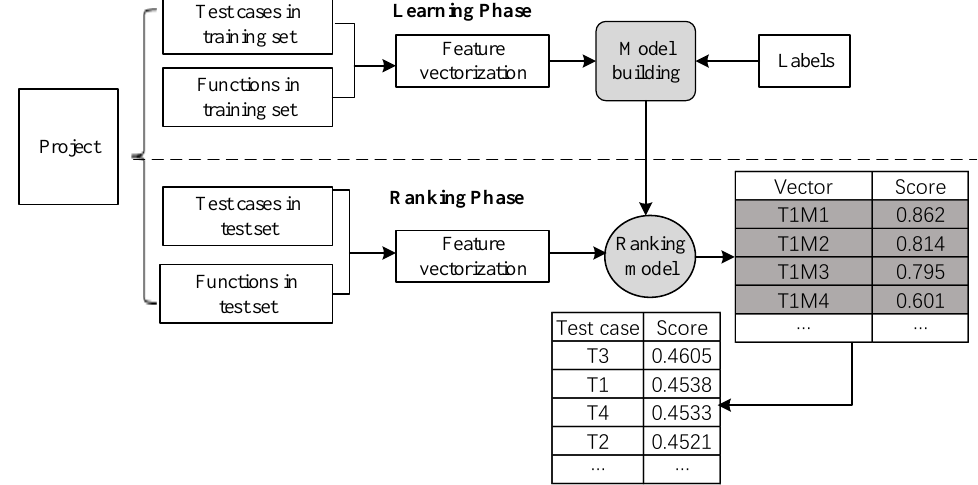
Figure 2. Overview of the approach to learning to prioritize test cases for CAD